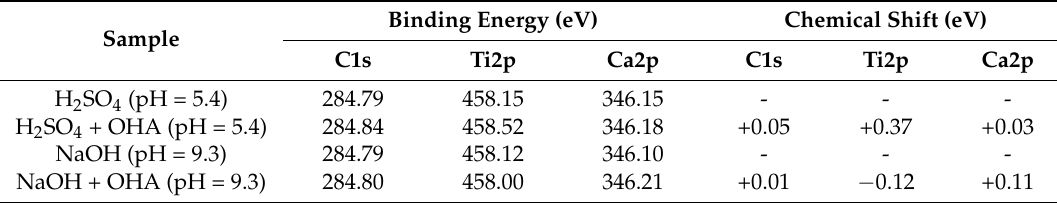
Table 2. Binding energies of elements on perovskite surface.